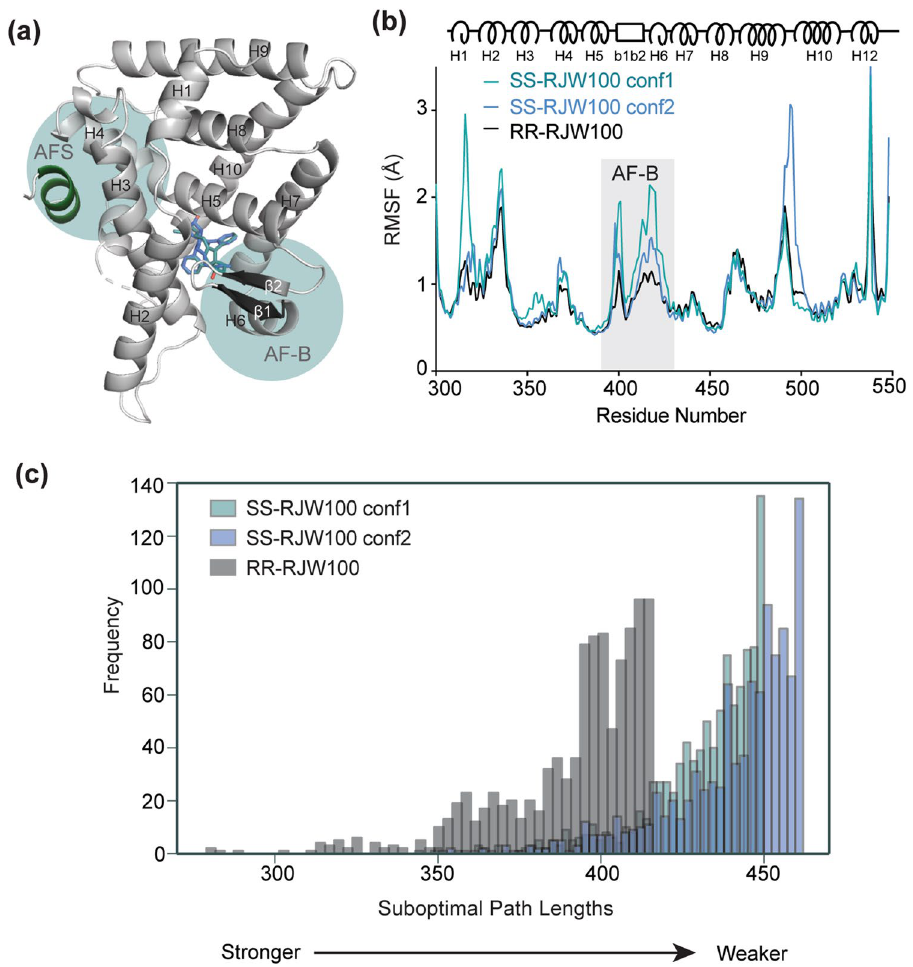
Figure 7. Weaker allosteric signalling by SS-RJW100 in MDS. ( a ) Model of the LRH-1 LBD with the AF-B and AFS highlighted in cyan. ( b ) RMSFs for each complex over the course of the 1 microsecond simulation. The diagram at the top of the graph indicates the position in the protein. Grey box indicates the AF-B. ( c ) Histogram of the top 1000 suboptimal paths between AF-B and the AFS for the three